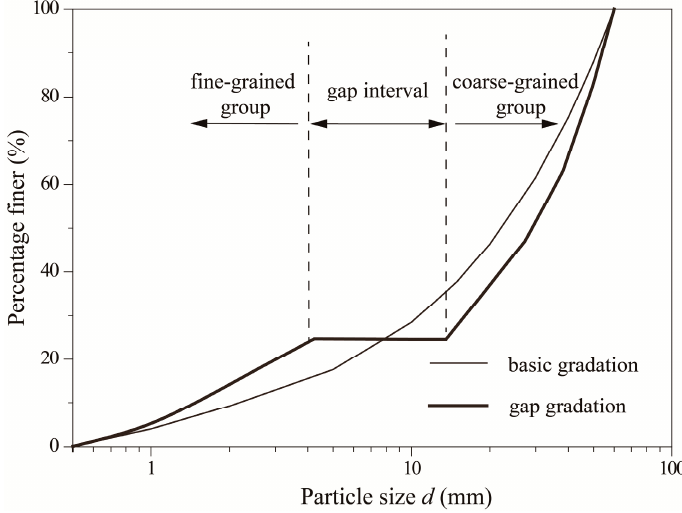
Figure 1. Definition of a gap gradation generated from a continuous gradation.